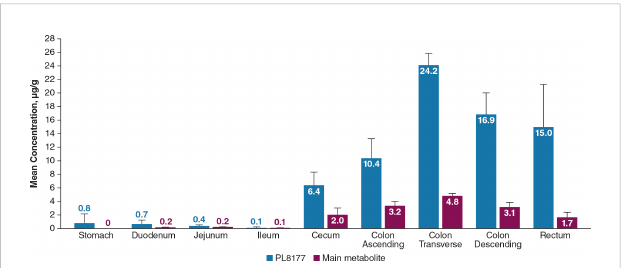
FIGURE 12 Mean concentration of PL8177 and the main metabolite in the GI tract of dogs at 6 hours after a single oral 20-mg dose. Levels of main metabolite in stomach were below the limit of quanti fi cation in all samples. GI,